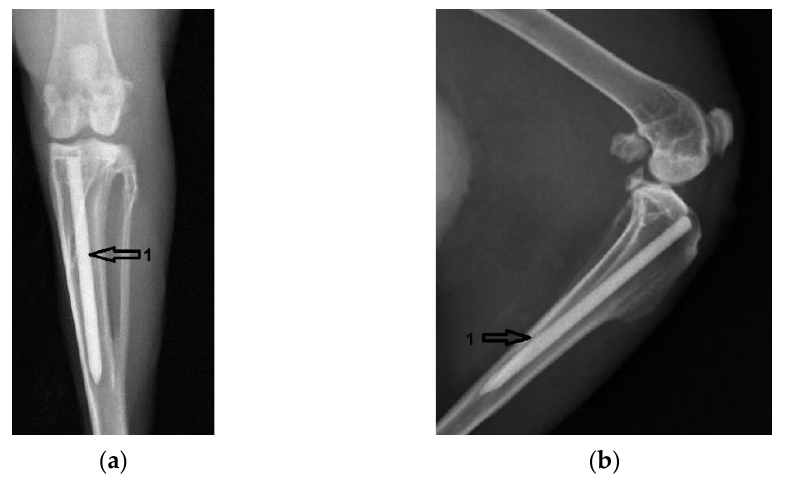
Figure 4. Group one, Mg – 1Ca intramedullary pins, after surgery. 1-position of the Mg-1Ca pin: ( a ) Coronal view; ( b ) Lateral view.